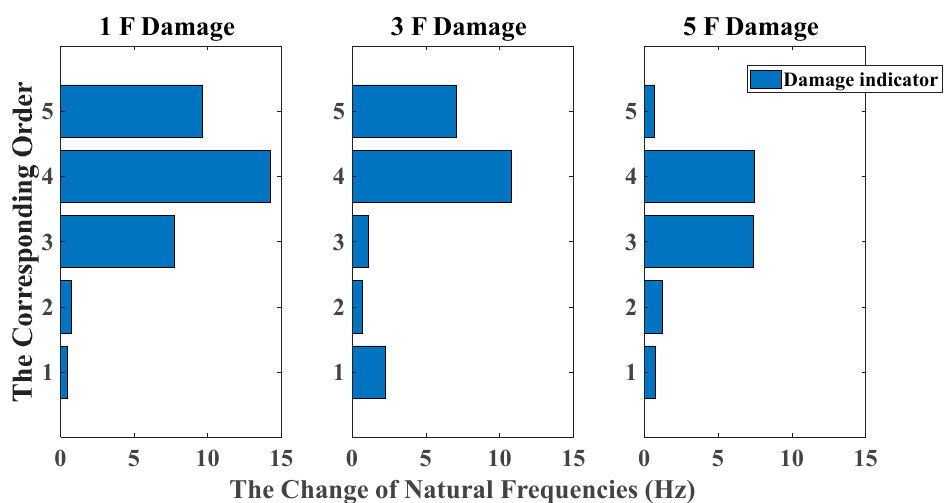
Figure 25. Damage detection results based on the change of natural frequencies (removing braces, white noises excitation, data length = 4000).